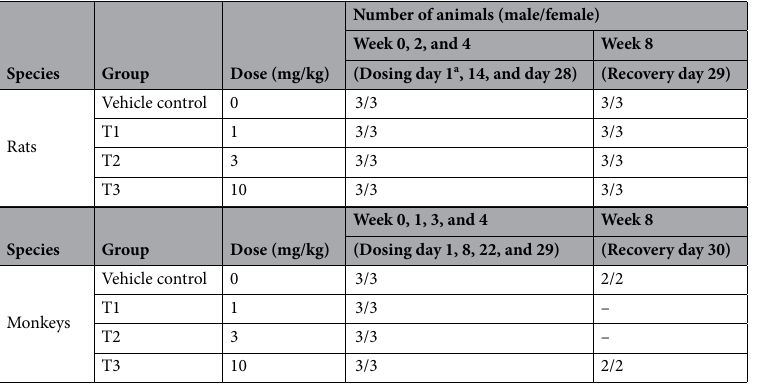
Table 3. Experimental design of the current toxicity study of GX-G3 treatment in rats and monkeys. a Rat samples for 0 h on Day 1 (Week 0) collected from pre-dosing